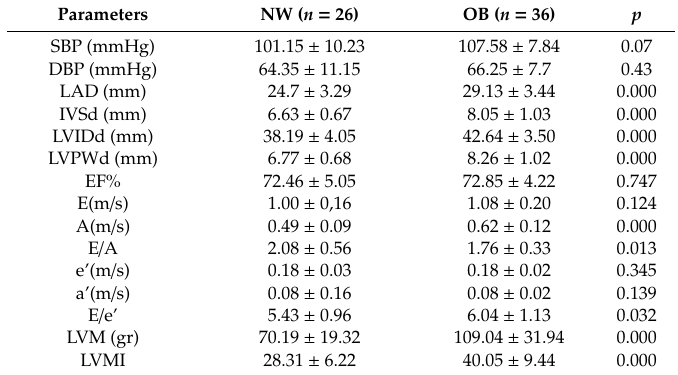
Table 3. Comparison of echocardiographic measurements between non-overweight and obese children.